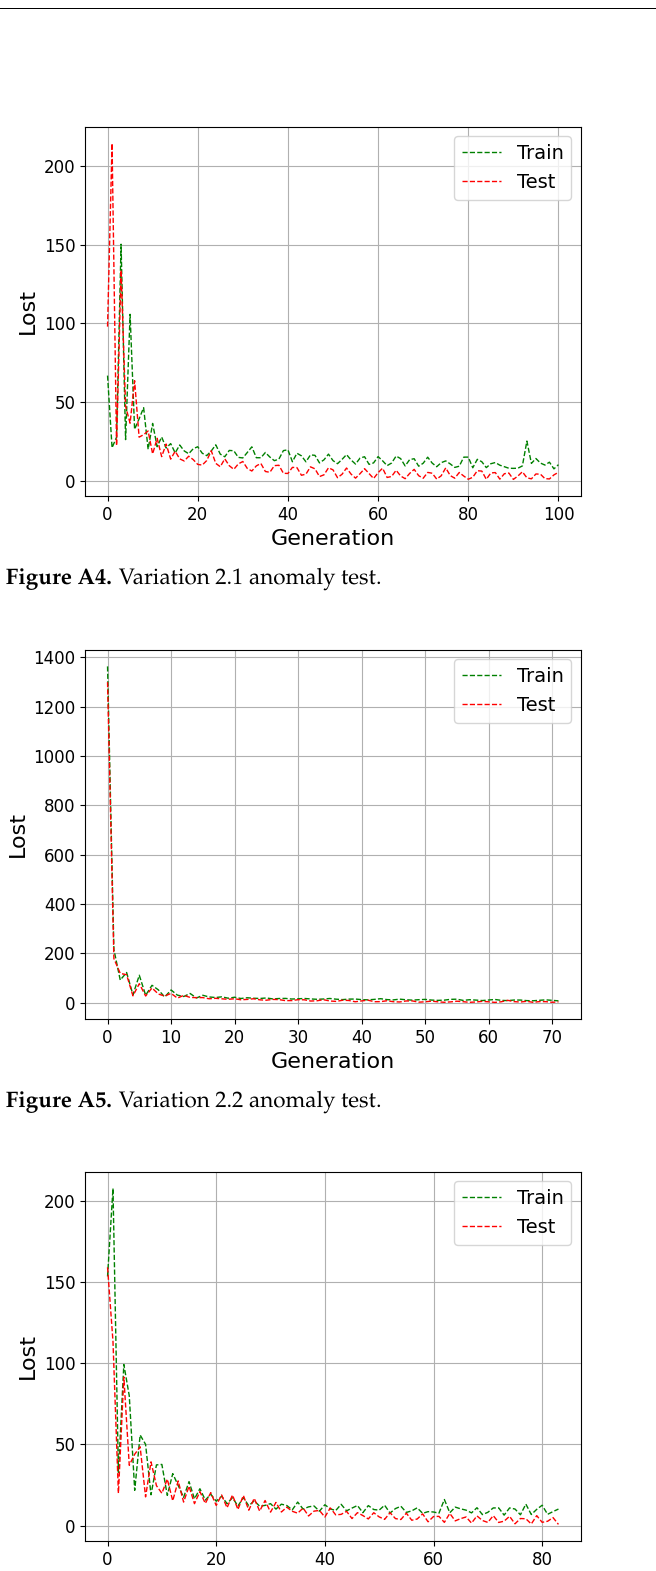
Figure A6. Variation 2.3 anomaly